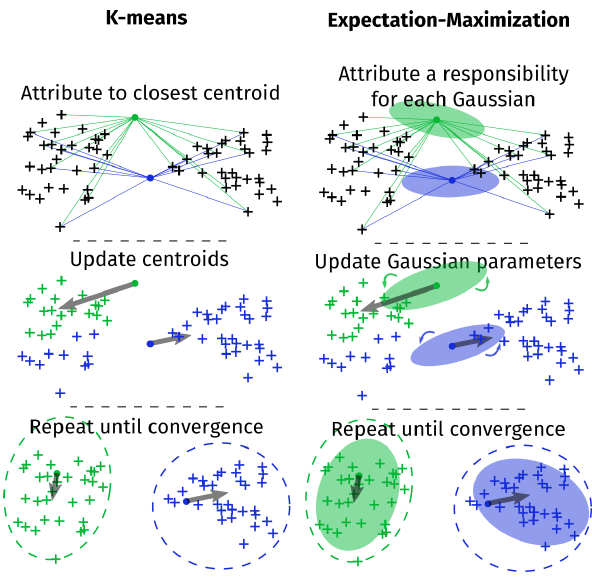
Figure 5. Illustration of the K -means and expectation– maximization algorithm on two-dimensional artificial data with two clusters.